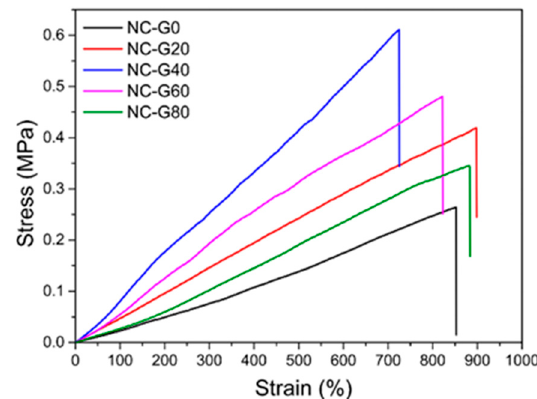
Figure 6. Stress-strain curves of NC-G gels with different glycerol content.